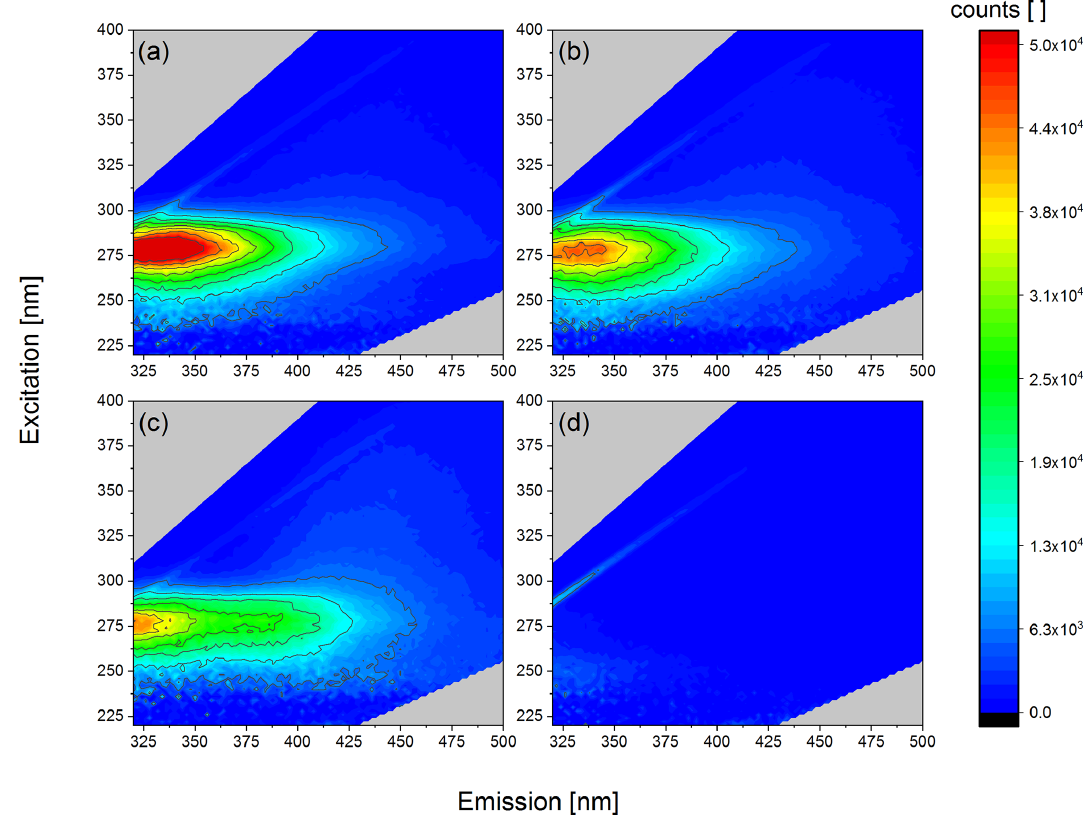
Figure 7. Fluorescence excitation–emission maps of obtained SPP samples. (a) Sample A, 1 : 10 diluted with ultrapure water. (b) Sample B, 1 : 10 diluted with ultrapure water. (c) Sample C01. (d) Sample D (washed